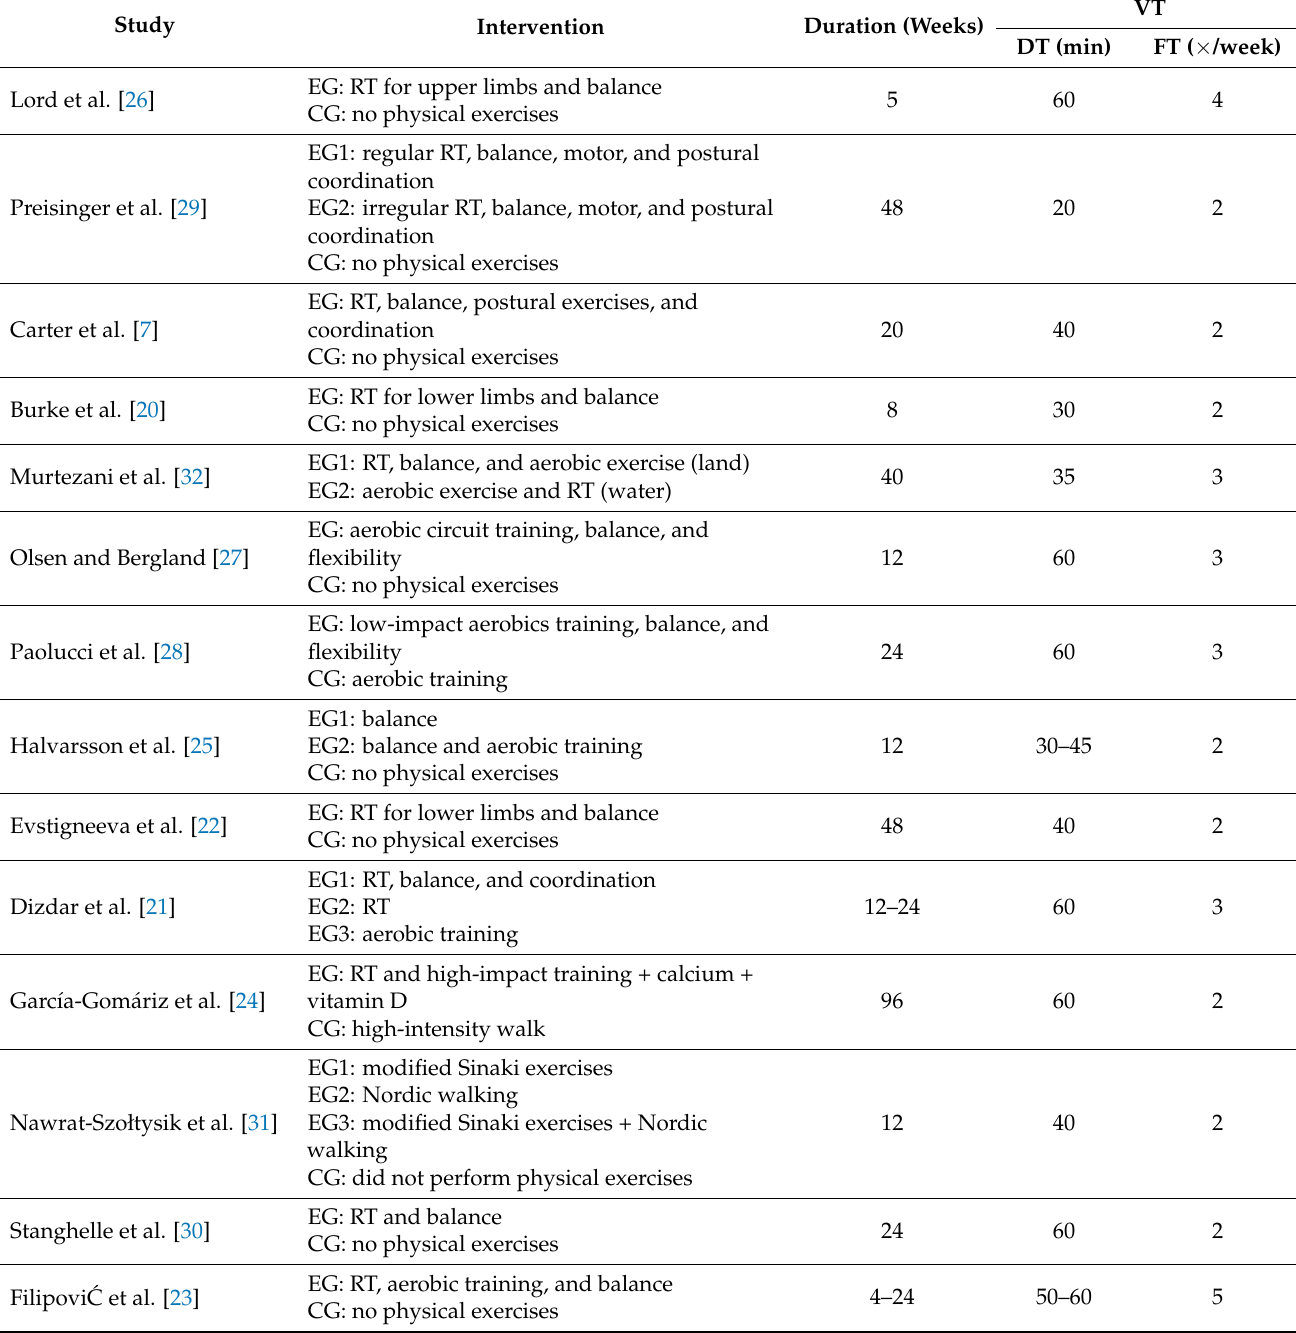
Table 4. Study intervention